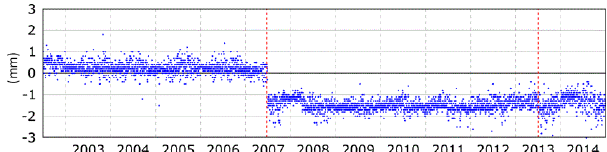
Figure 3. EPN station KLOP (Kloppenheim, Frankfurt, Germany) ZTD differences time series between solutions processed with indi- vidual and type mean antenna calibration models. Two instrumen- tation changes occurred at the station (marked by vertical dashed red lines): the first in 27 June 2007, when the previous antenna was replaced with a TRM55971.00 and a TZGD radome, and the sec- ond in 28 June 2013 with the installation of a TRM57971.00 and a TZGD